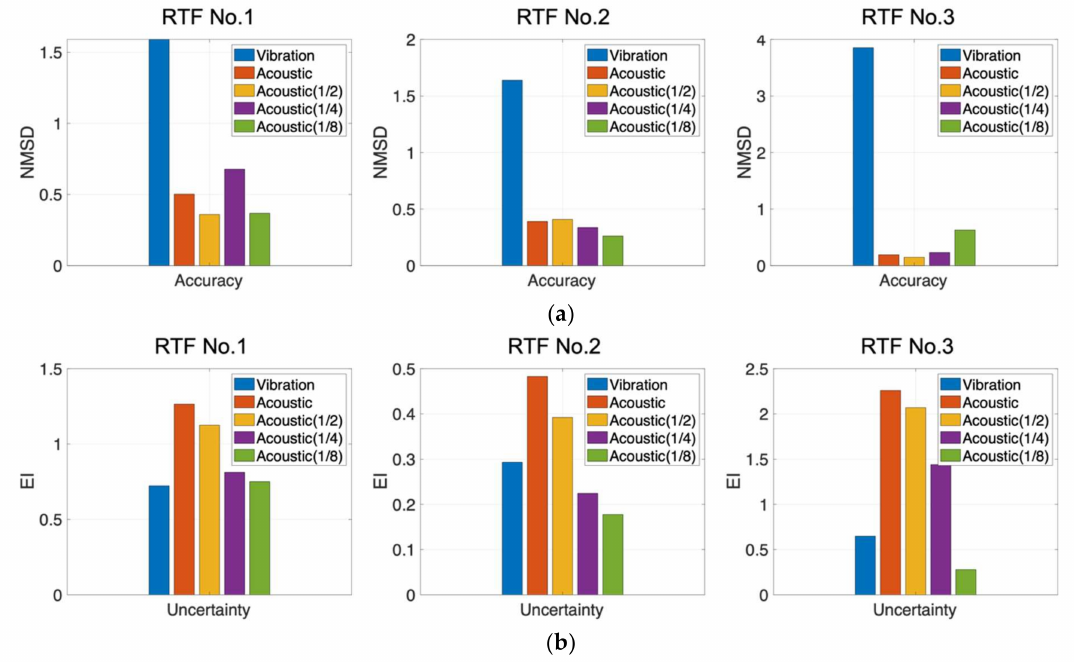
Figure 9. Average NMSD ( a ) and EI ( b ) of the vibration sensor, acoustic sensor, and acoustic sensor with different data intervals (1, 2, 4, and 8